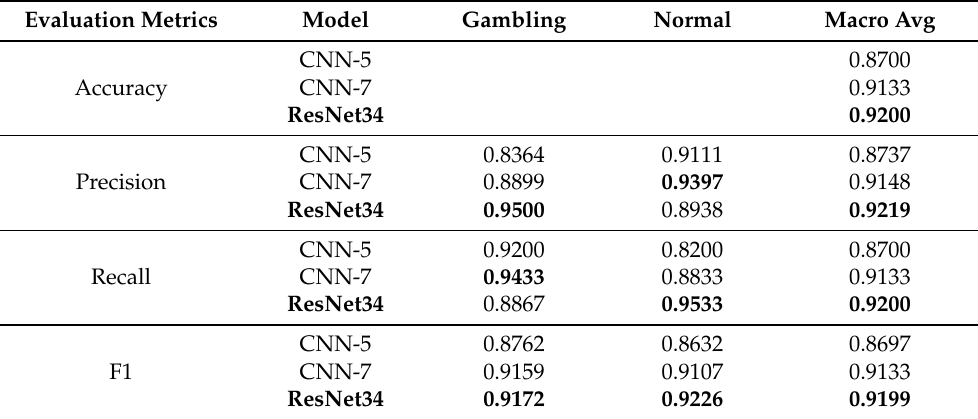
Table 2. Results of ResNet34, CNN-5, and